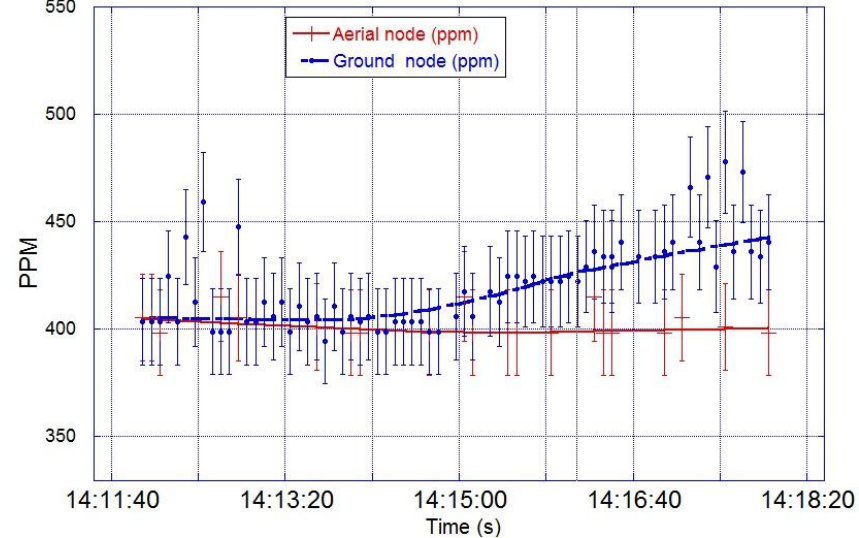
Figure 17. CO 2 readings from the ground node and aerial node during the field testing at Christmas Creek, QLD the 23 July